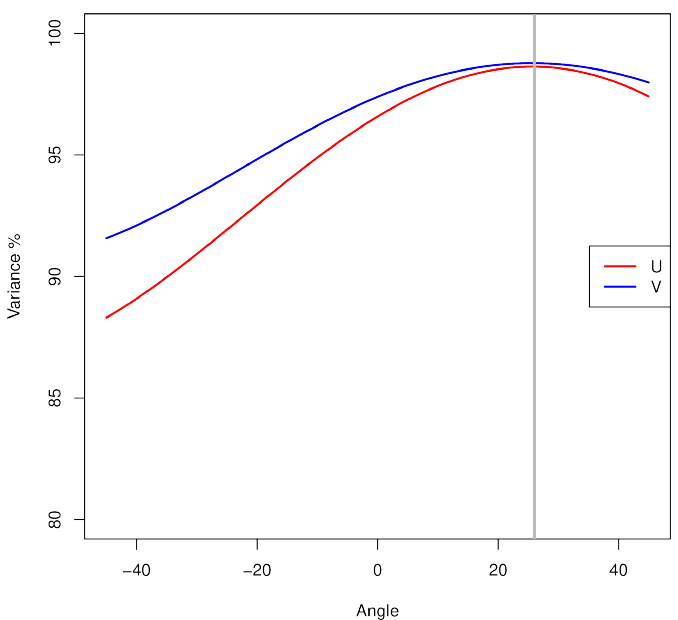
Figure 9. Variance corresponding to the leading principal component after a rotation was applied to the wind field components from the WIC anemometer before the principal component analysis (PCA) was computed. The maximum amount of variance in PC1 was obtained with an angle of 26 ◦